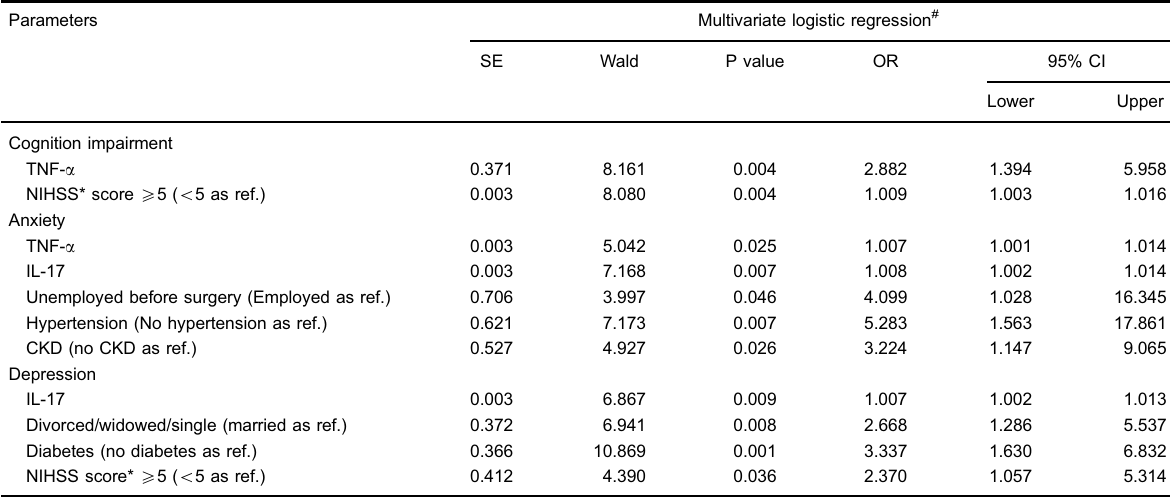
Table 3. Independent factors associated with cognition impairment, anxiety, and depression of acute ischemic stroke (AIS) patients. Parameters Multivariate logistic regression # SE Wald P value OR 95% CI Lower